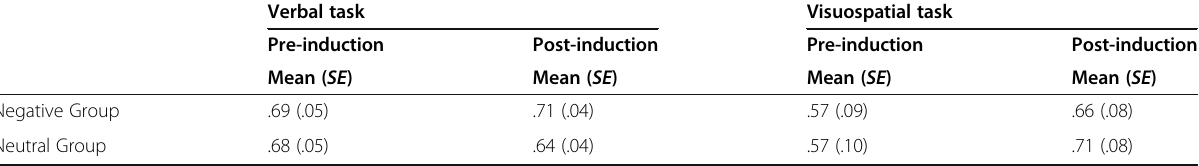
Table 1 The mean scores of pre-post induction trials for VE and VI tasks in each group.